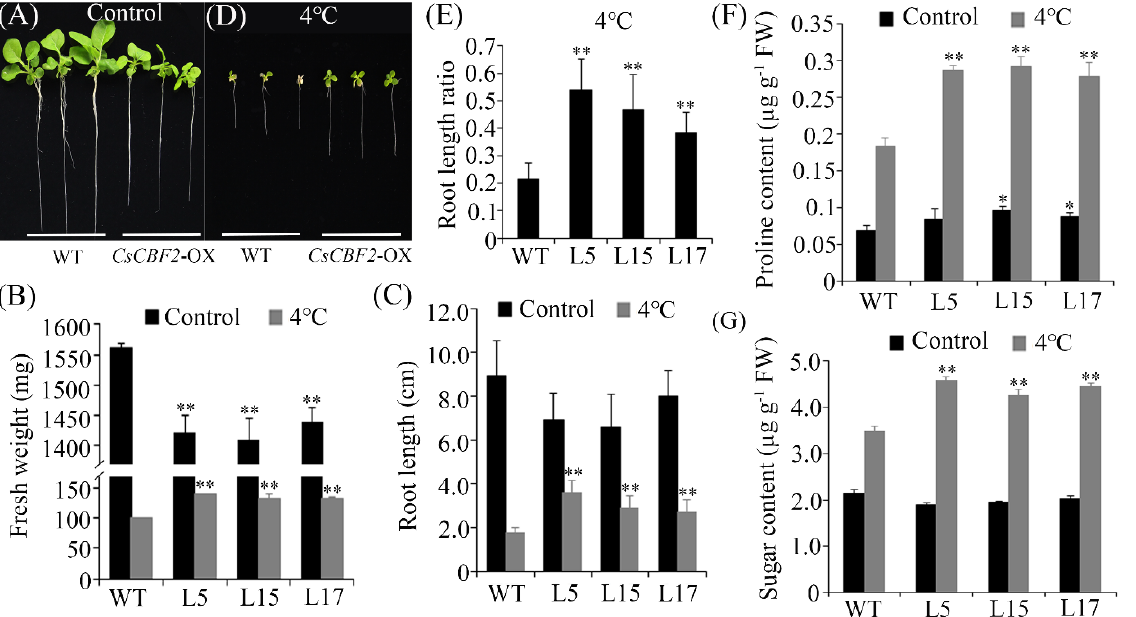
Figure 5. Phenotypic and physiological responses of CsCBF2 ‐ overexpressing transgenic plants under cold stress conditions. Data are means ±standard deviation (SD) of three independent experiments. Significant differences between WT and transgenic plants under control and cold stress conditions are indicated by * p < 0.05, ** p < 0.01; Student’s t ‐ test. ( A , D ) exhibit the phenotypes of CsCBF2 ‐ overexpressing tobacco plants ( CsCBF2 ‐ OX) and wild type tobacco plant (WT) growing on 1/2 MS culture medium for 20 days, respectively, under normal growth conditions (control) and cold stress conditions (4 °C). ( B ) The fresh weight of CsCBF2 ‐ OX L5, L15, L17, and WT under normal (control) and cold stress (4 °C) conditions, after growing on 1/2 MS culture medium for 20 days. ( C ) The root length of CsCBF2 ‐ OX L5, L15, L17, and WT under normal (control) and cold stress (4 °C) conditions, after growing on 1/2 MS culture medium for 20 days. ( E ) The root length ratio of CsCBF2 ‐ OX L5, L15, L17, and WT. The root length ratio is the root length of CsCBF2 ‐ OX L5, L15, L17, and WT under cold stress conditions (4 °C) correspondingly to that under normal growth conditions (control). ( F , G ) respectively represents the proline and soluble sugar content in CsCBF2 ‐ OX L5, L15, L17, and WT under normal growth conditions (control) and cold stress (4 °C).